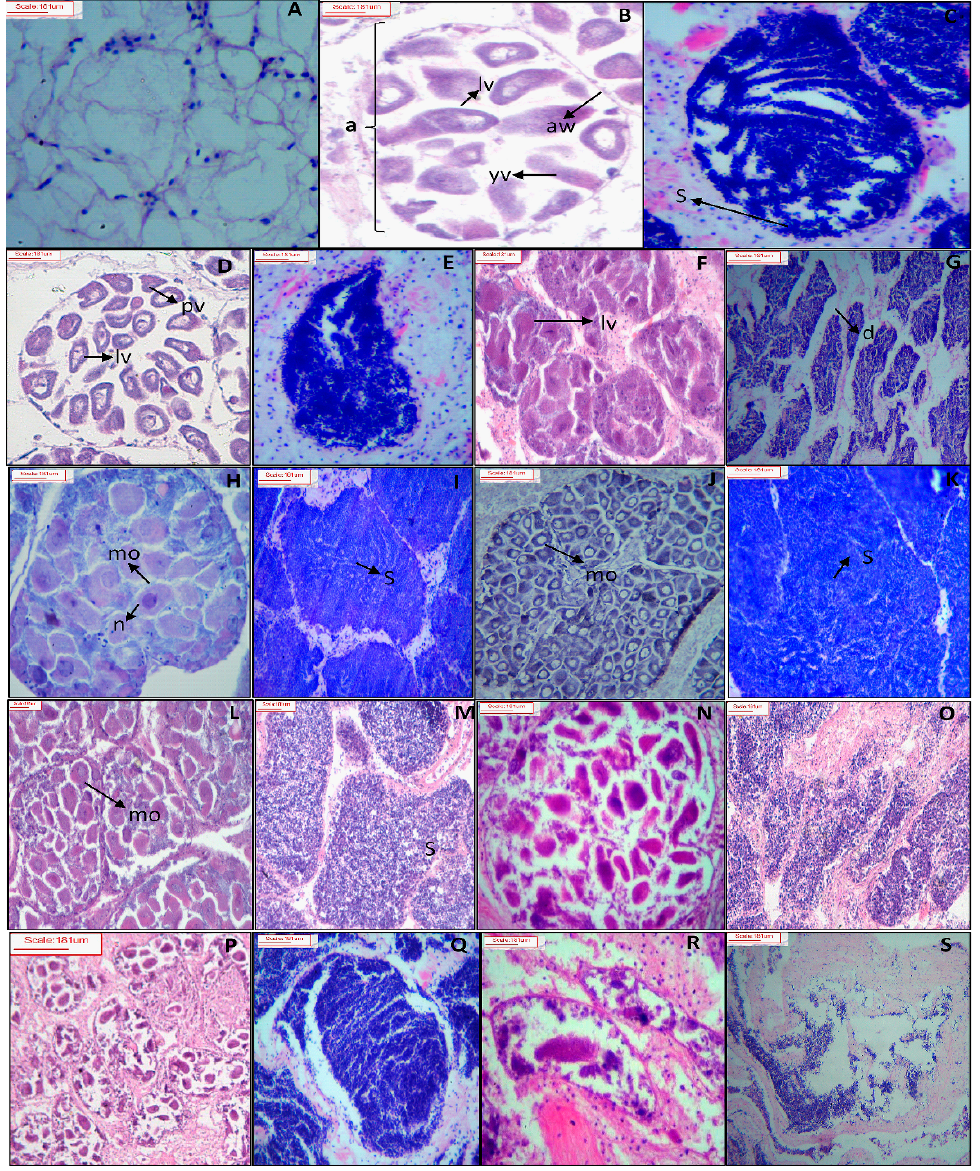
Figure 2. Transverse histological section of the female and male gonads of green mussel Perna viridis collected from the coastal waters of Bangladesh during November 2017 to October 2018. Resting